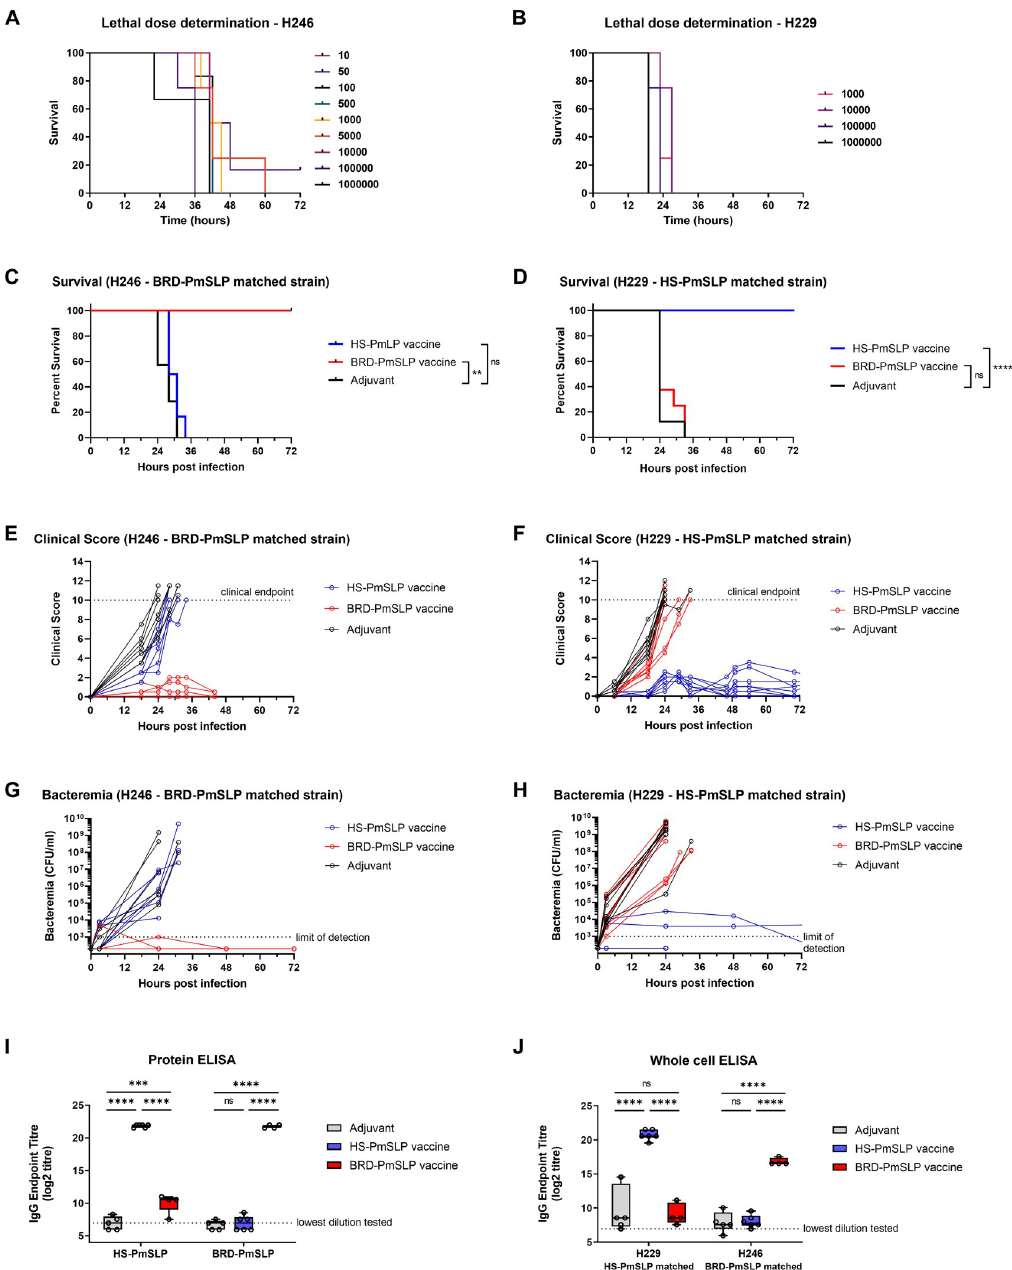
Fig 2. Evaluation of PmSLP vaccines using a mouse sepsis model. A. Determination of the lethal dose for a PmSLP group 1 (H246) and B. a group 3 (H229) isolate. N = 3–6 mice per group (3 mice per group for infectious dose of 10 6 CFU; 4 mice per group use for infectious doses between 500 CFU to 10 5 CFU; 6 mice per group for doses lower than 500 CFU). C. Survival of vaccinated and control animals after challenge with the BRD-PmSLP antigen-matched strain H246. N = 4 BRD-PmSLP, N = 6 HS-PmSLP, N = 7 Adjuvant). D. Survival of vaccinated and control animals after challenge with the HS-PmSLP antigen- matched strain H229. N = 8 per group. Log-rank (Mantel Cox) tests performed for survival curve comparisons; **** , p < 0.0001; ** , p < 0.01; ns, not significant. E,F. Cumulative clinical scores depicted for individual animals over the course of 72 hours. Dotted lines at 10 indicate the clinical cut-off used for determining humane endpoint. G,H. Bacterial burden in tail bleeds depicted for individual animals over the duration of the challenge trial. I. Serum IgG titre in vaccinated or adjuvant control animals measured using purified BRD-PmSLP or HS-PmSLP proteins as capture. J. Serum IgG titre in vaccinated or adjuvant control animals measured using heat inactivated whole bacteria as capture. For I and J, boxplot with individual animals is shown. 2-way ANOVA with Tukey’s multiple comparisons test performed on log2 transformed data to calculate p-value. *** , p < 0.005; **** , p < 0.0001; ns, not significant.